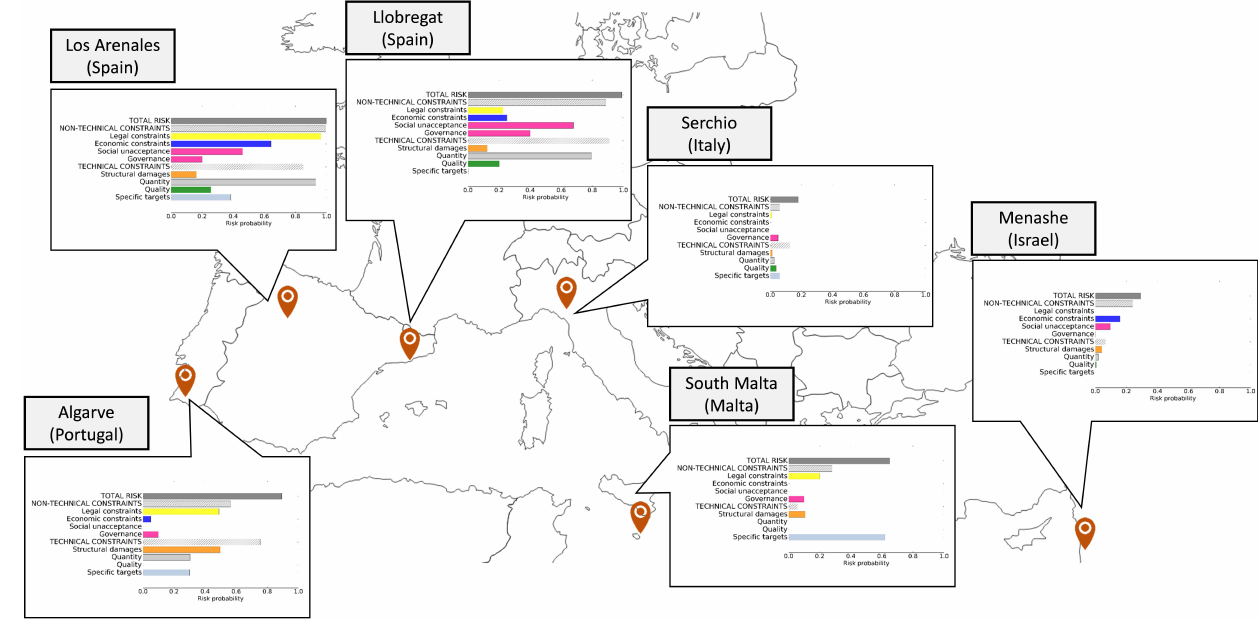
Figure 6. Risk in the different MAR